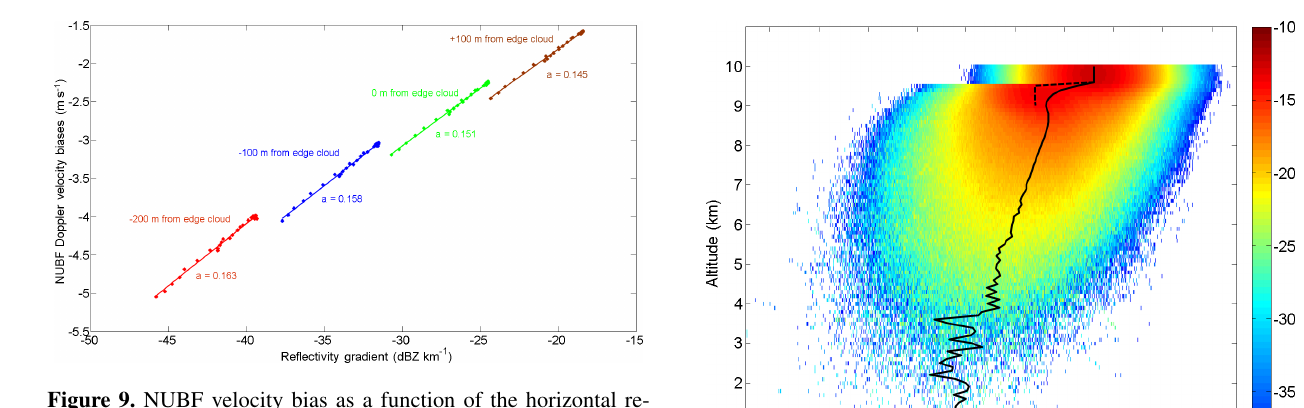
Figure 9. NUBF velocity bias as a function of the horizontal re- flectivity gradient for a horizontal integration of 500m, estimated for four positions relative to the box-cloud edge: − 200m (red), − 100m (blue), 0m (green), and + 100m (brown). Optical depths of the box cloud are 0.1, 1, and 3. Vertical (downdraft) veloc- ity is set to 6ms − 1 . The proportional coefficient value α (in ms − 1 (dBZkm − 1 ) − 1 ) between NUBF velocity bias and horizon- tal reflectivity gradient is also given.